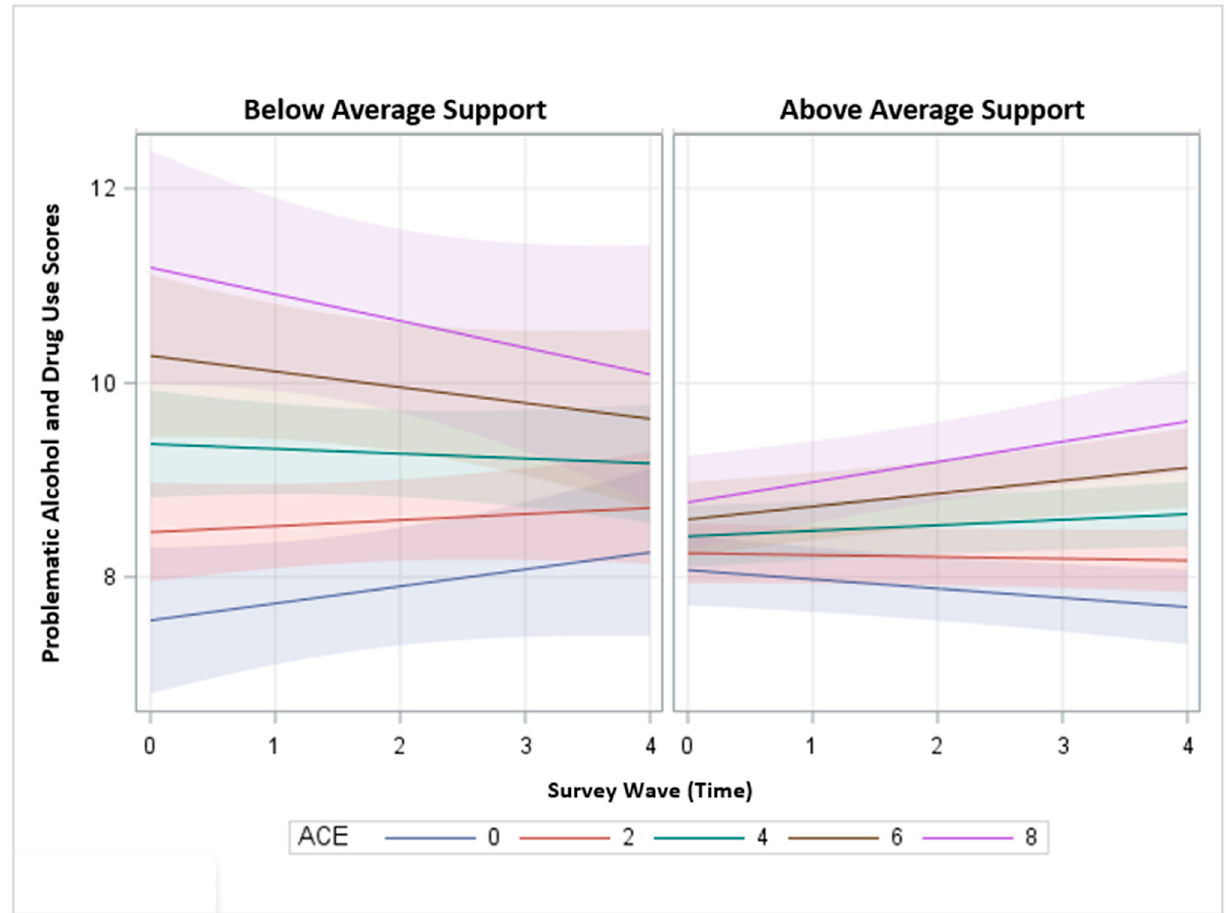
Figure 2. Problematic alcohol and drug use scores over time by level of ACE exposure, controlling for covariates and paneled by perceived social support.